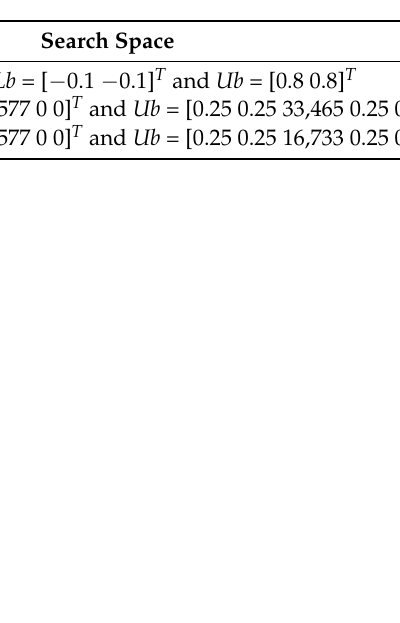
Table 6. Search space of three cases.